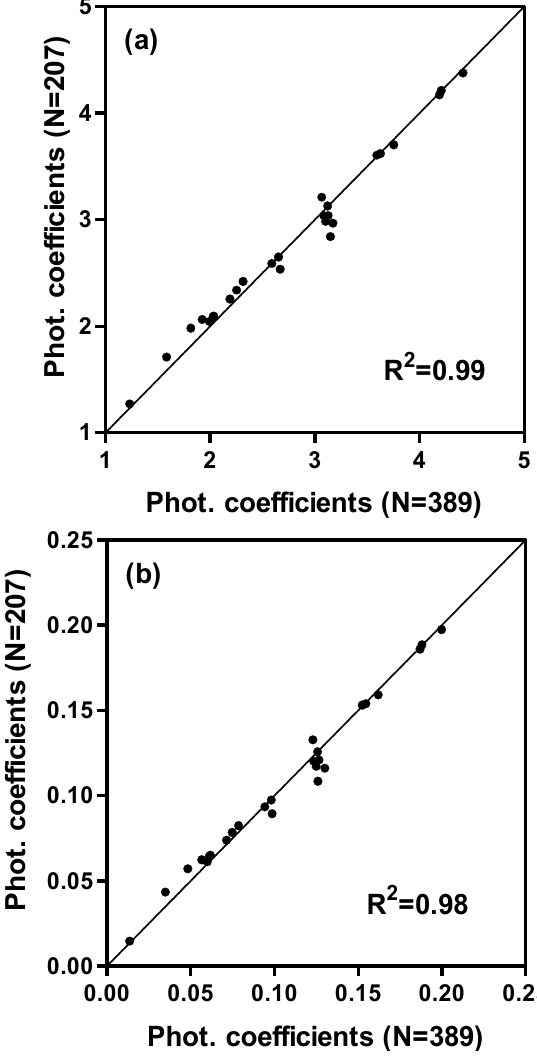
Figure 6. Comparisons of the photoperiod coefficients for the ( a ) additive model (c (°C −1 h −1 )) and for the ( b ) multiplicative model (c* (h −1 )). These coefficients were calculated by least squares using the whole data set (N = 389) and using the subset (N = 207).